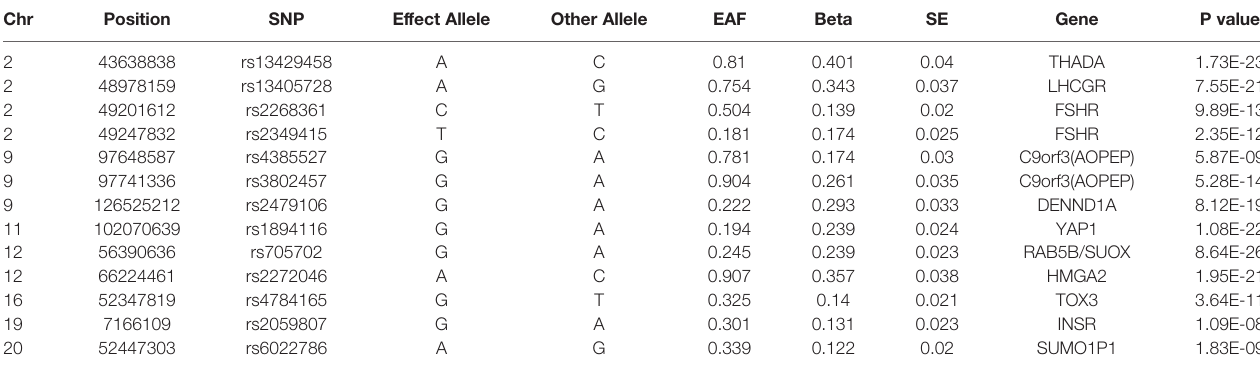
TABLE 2 | PCOS SNPs used to construct the instrument variable in Asians. Chr Position